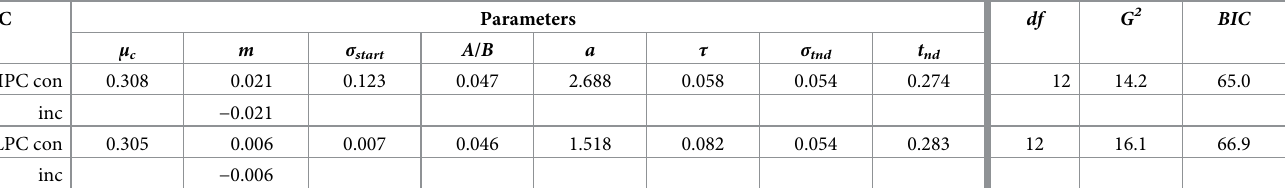
Table 3. Estimated parameter values obtained by fitting the DMC model to the data of Experiment